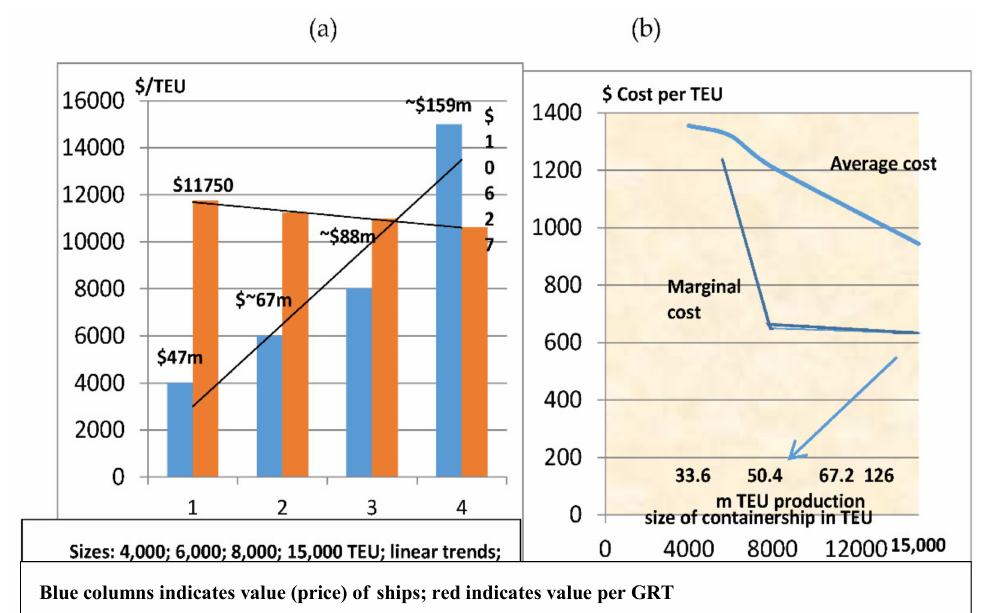
Figure 6. ( a ) Capital cost, total and average cost per size, ( b ) AC, and MC in CM per size, 1994–2013. Source: Author, excel and numbers from Furuichi and Otsuka (2015).